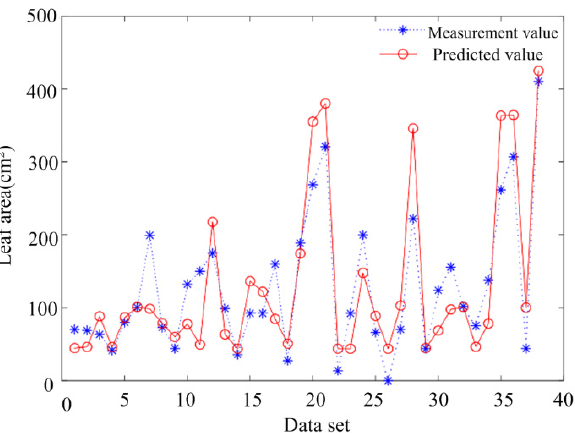
Figure 12. Comparison between the real leaf areas and predicted values in the data prediction set.